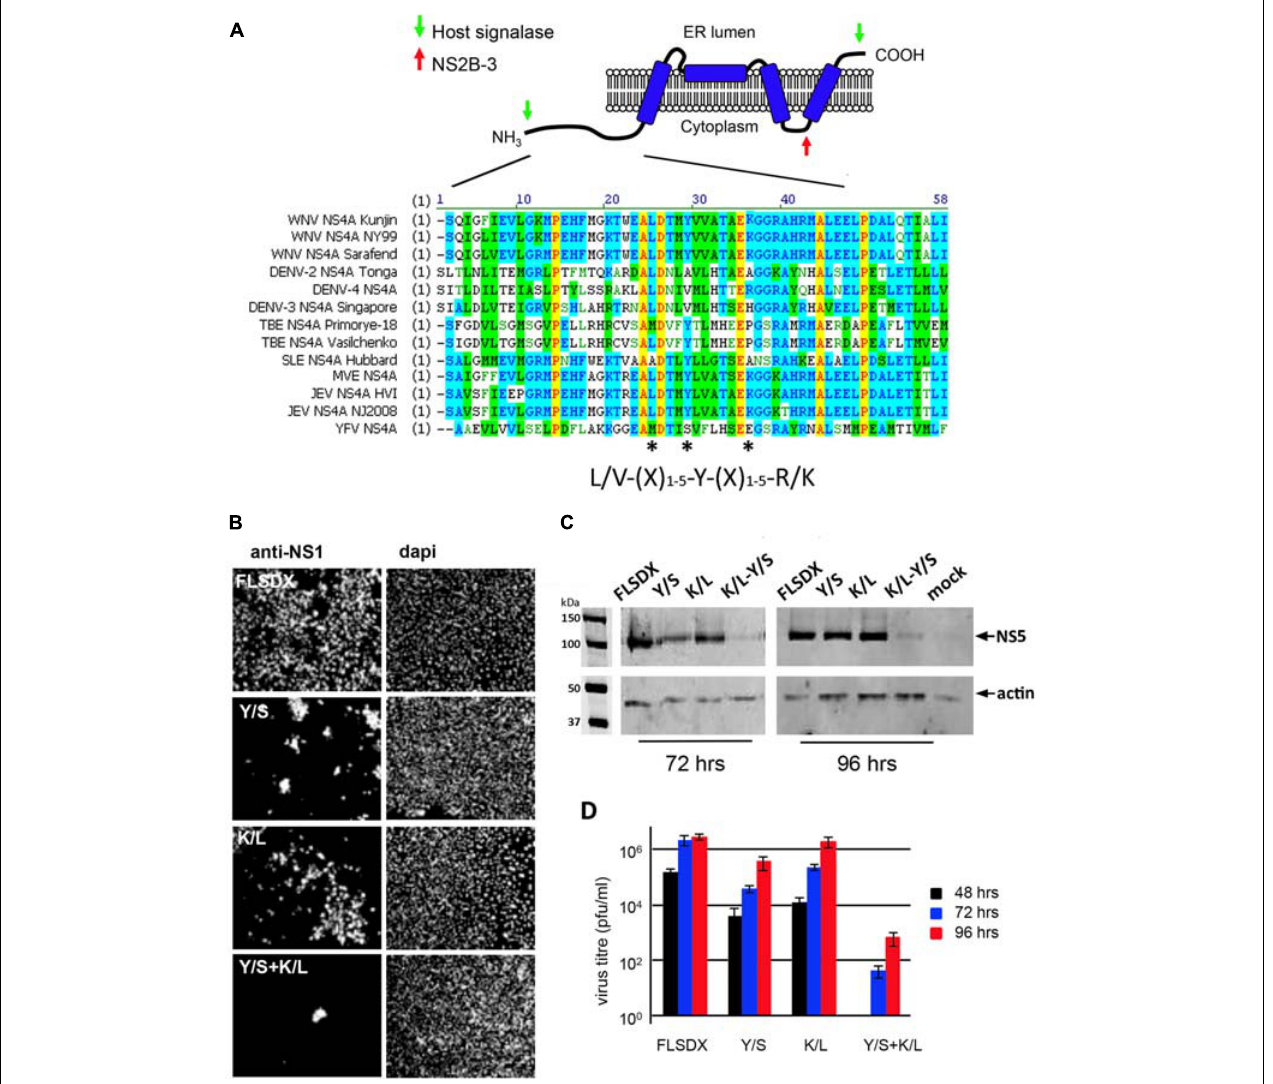
FIGURE 2 | (A) WNV KUN NS4A protein encodes for a potential CRAC motif. NS4A 25 L-(X)- 29 Y-(X)- 36 K region is highly conserved within the Japanese encephalitis subgroup of the flavivirus genus. Various NS4A sequences from the flavivirus genus were aligned using ClustalW software (Vector NTI; Invitrogen). Light gray residues are conservative and the amino acids comprising the CRAC motif are highlighted with asterisks (*). The predicted topology of NS4A in the endoplasmic reticulum membrane is modified based on the study by Miller et al. (2007). (B) Mutation of the NS4A CRAC motif restricts WNV KUN replication. Single (Y/S or K/L) and double residue (Y/S + K/L) mutations were generated in the CRAC motif in FLSDX using site-directed mutagenesis. RNA was transcribed and transfected into Vero cells and replication was assessed by IF analysis at 72 h.p.e. with antibodies raised against the WNV NS1 protein and counterstained with the nuclear dye dapi. (C) In addition, protein lysates were collected at 72 and 96 h.p.e. and analyzed by Western blotting using the antibodies raised against WNV NS5 protein and compared to the internal control actin. (D) Tissue culture fluid was collected at 48, 72, and 96 hpe and each time point was analyzed by plaque assay, and visible plaques were used to calculate titers for FLSDX and the Y/S, K/L and Y/S + K/L mutants. Error bars indicate standard deviation derived from replicate experiments ( n =